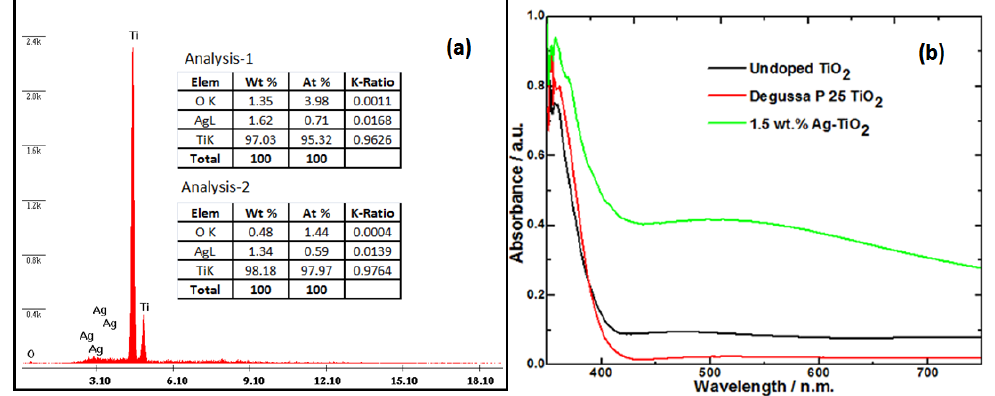
Figure 3. ( a ) Elemental analysis (EDS) of the silver doped TiO 2 showing the presence of Ti and Ag species; ( b ) UV-Vis diffuse reflectance spectra (DRS) of Ag-doped TiO 2 , TiO 2 and Degussa P25